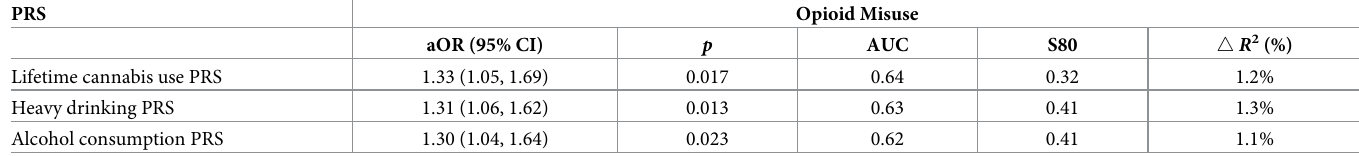
Table 2. Cannabis and alcohol consumption PRS associations with the likelihood of ever misusing opioids in the whole sample ( N = 1,103). PRS Lifetime cannabis use PRS Heavy drinking PRS Alcohol consumption PRS Note. Participant sex, intervention status, cohort, and 10 ancestry-specific principal components were included as covariates. AUC = area under the curve; S80 = sensitivity corresponding to 80%